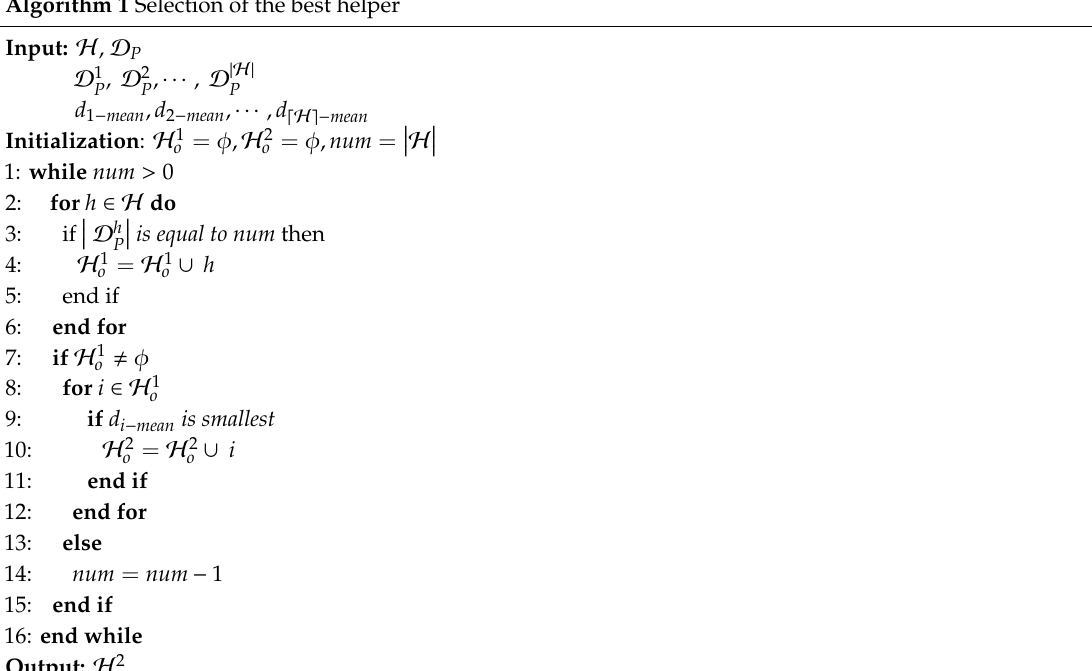
Algorithm 1 Selection of the best helper